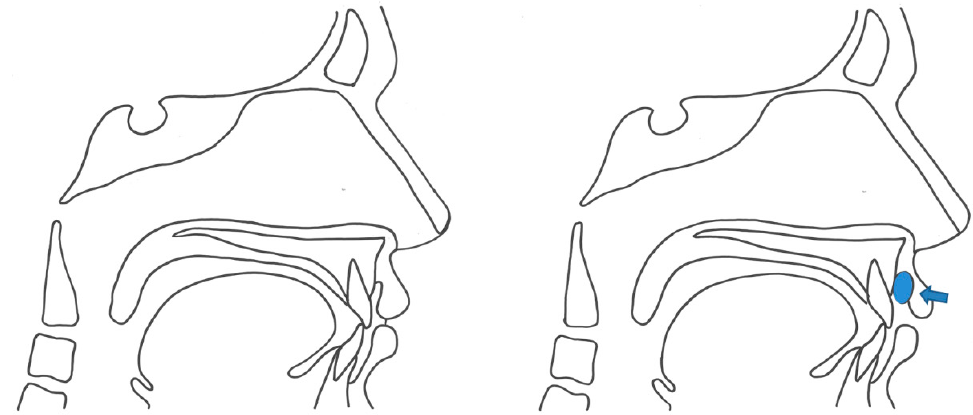
Figure 3. Position of the bulb (LP, lip pressure).